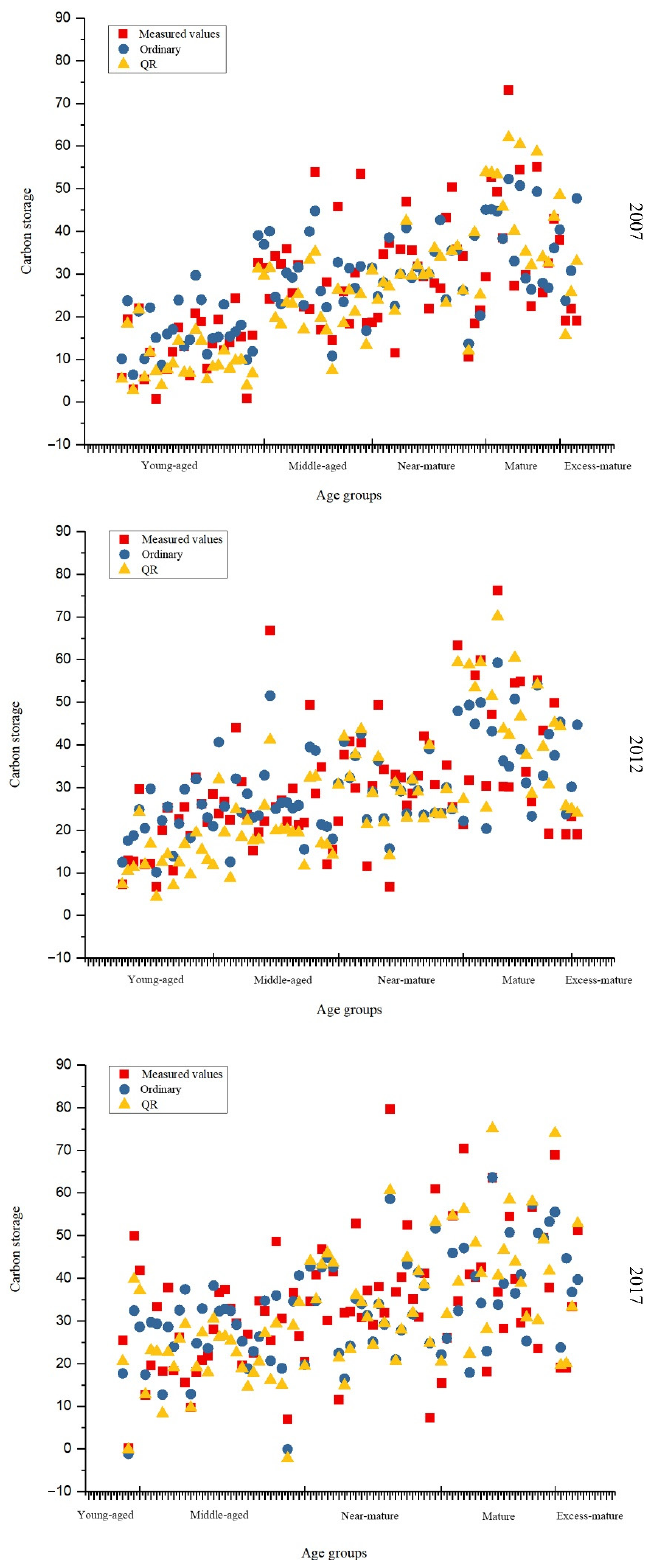
Figure 4. The results of the ordinary panel data model based on least squares, the quantile model, and the measured actual